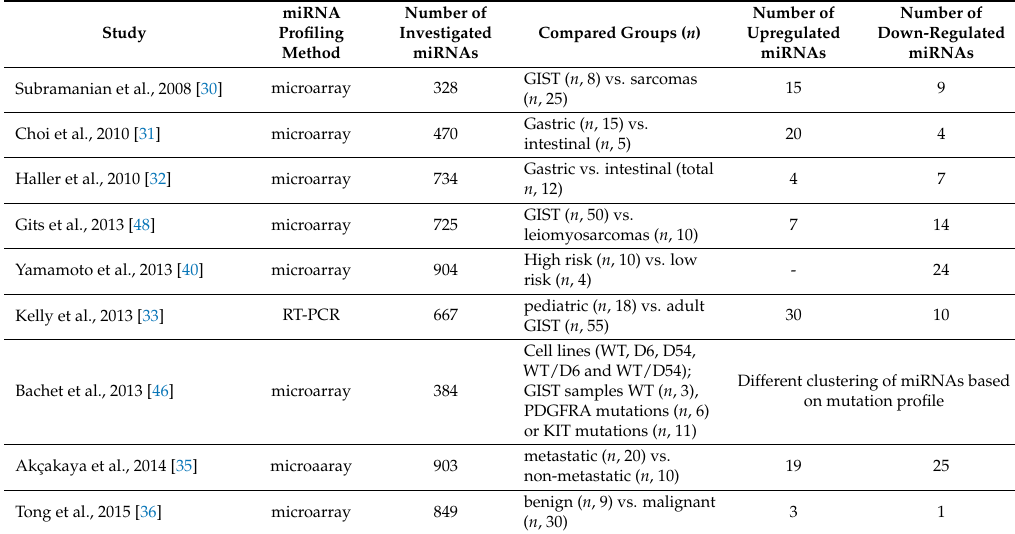
Table 1. Studies on miRNA expression profiles in gastrointestinal stromal tumors